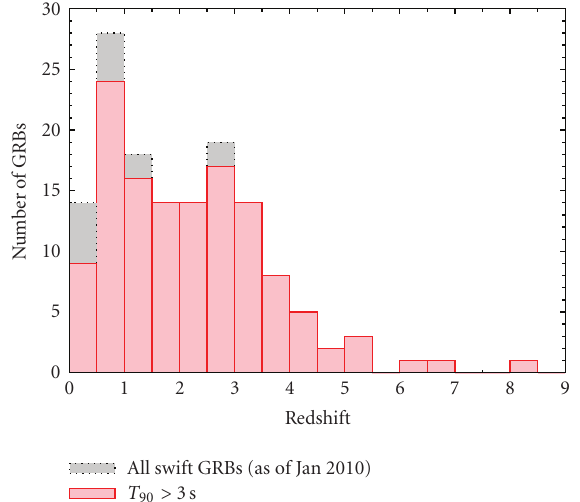
Figure 1: Redshift distribution of Swift GRBs detected to-date.